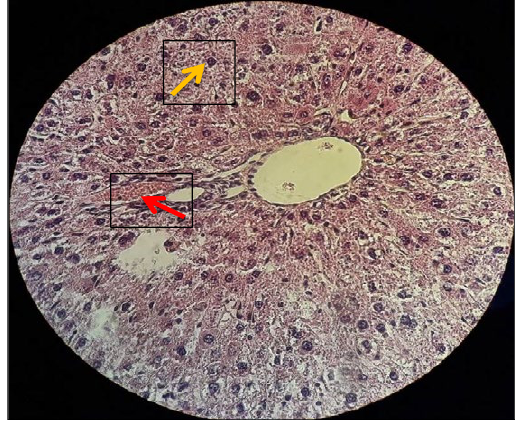
Fig. 6: Photomicrograph of rat liver tissue in experimental Figure 6: Photomicrograph of rat liver tissue in experimental group 2. In this group, necrosis was group 2. In this group, necrosis was more intense (yellow more intense (yellow arrow), and There were also signs of hemorrhage (red arrow). (Hematoxylin- arrow), and There were also signs of hemorrhage (red arrow). Eosin staining, magnification 400 ×). (Hematoxylin-Eosin staining, magnification 400 ×).